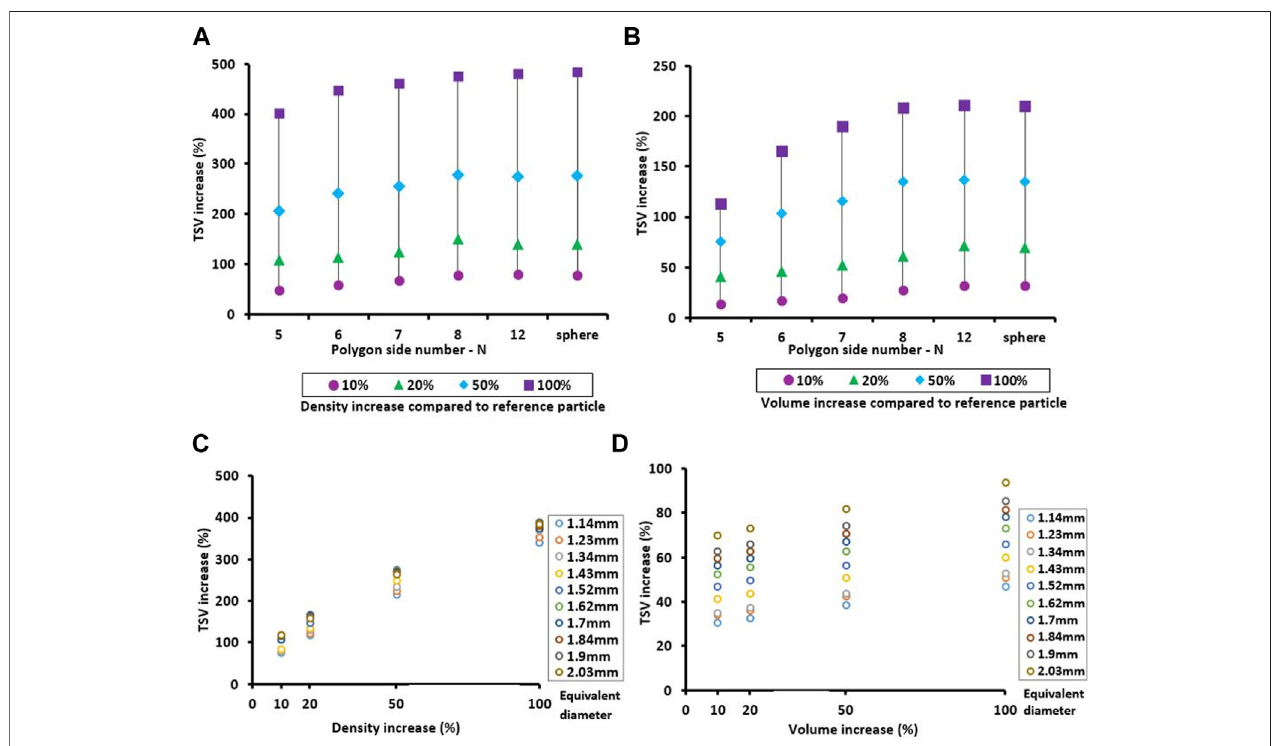
FIGURE9 |(A) Effects on TSV due toincreasing the initial particle density (1.1 gcm 3 ) by10,20, 50, and 100% forparticleswith shapes derived from polygons with side numbers of 5,6,7,8,12 (see Figure 3 ) and a sphere with diameter of 1 mm (i.e., the level of roundness increases from left to right). (B) Effects on TSV due to increasingtheinitialparticlevolume(volumeofaspherewithdiameterof1 mm)by10,20,50,and100%forthesameparticlesasinA. (C) Effectsofadensitygainby10, 20, 50, and 100% on TSVs for 10 randomly selected irregular particles (initial density = 1.1 gcm 3 ). (D) Impact of volume increase by 10, 20, 50, and 100% for the same 10 irregular MP particles as in (C) .